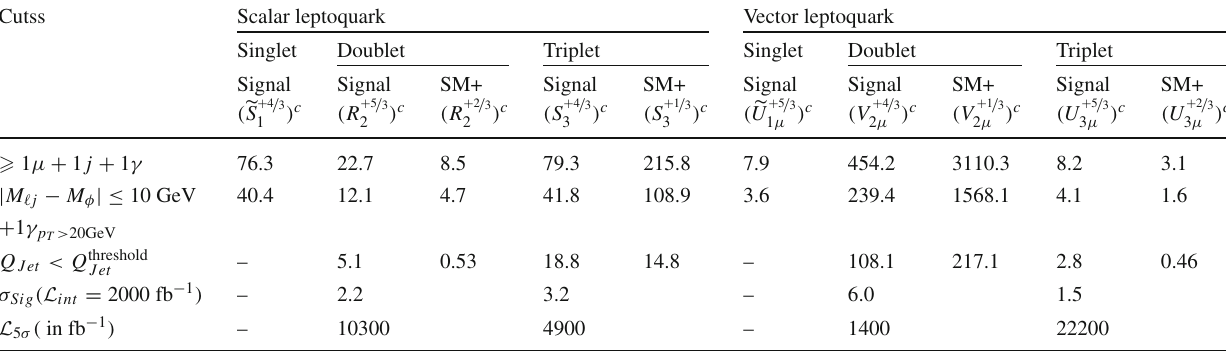
√ s = 1183 . 2 GeV and